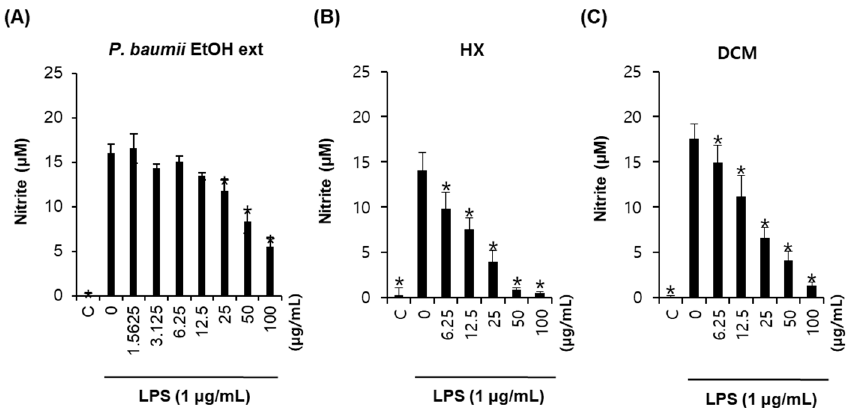
Figure 1. Anti-inflammatory effects of the EtOH extract of P. baumii and its fractions (hexane (HX) and dichloromethane (DCM) fractions): inhibition of lipopolysaccharide (LPS)-induced NO production in RAW264.7 mouse macrophages. ( A – C ) Inhibitory effects of the EtOH extract of P. baumii ( A ) and its hexane ( B ) and dichloromethane ( C ) fractions on LPS-induced NO production in RAW264.7 mouse macrophages. The cells were pretreated with the indicated concentrations of samples for 2 h and then exposed to 1 µ g/mL LPS for 24 h. * p < 0.05 compared to the LPS-treated value.